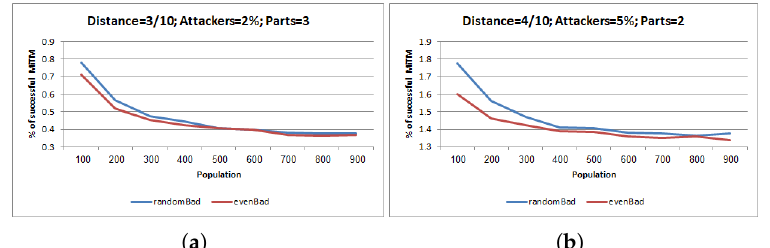
Figure 1. Fluctuating population. ( a ) Distance = 3/10; Attackers = 2%; Parts = 3. ( b ) Distance = 4/10; Attackers = 5%; Parts =